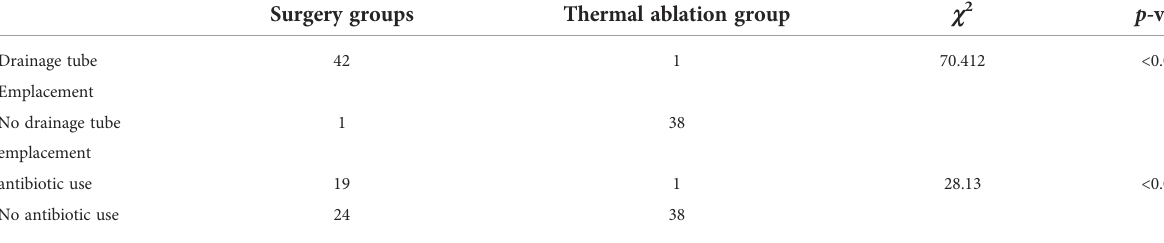
TABLE 6 Comparison of postoperative drainage tube emplacement and antibiotic use between the two groups ( x ± s ).